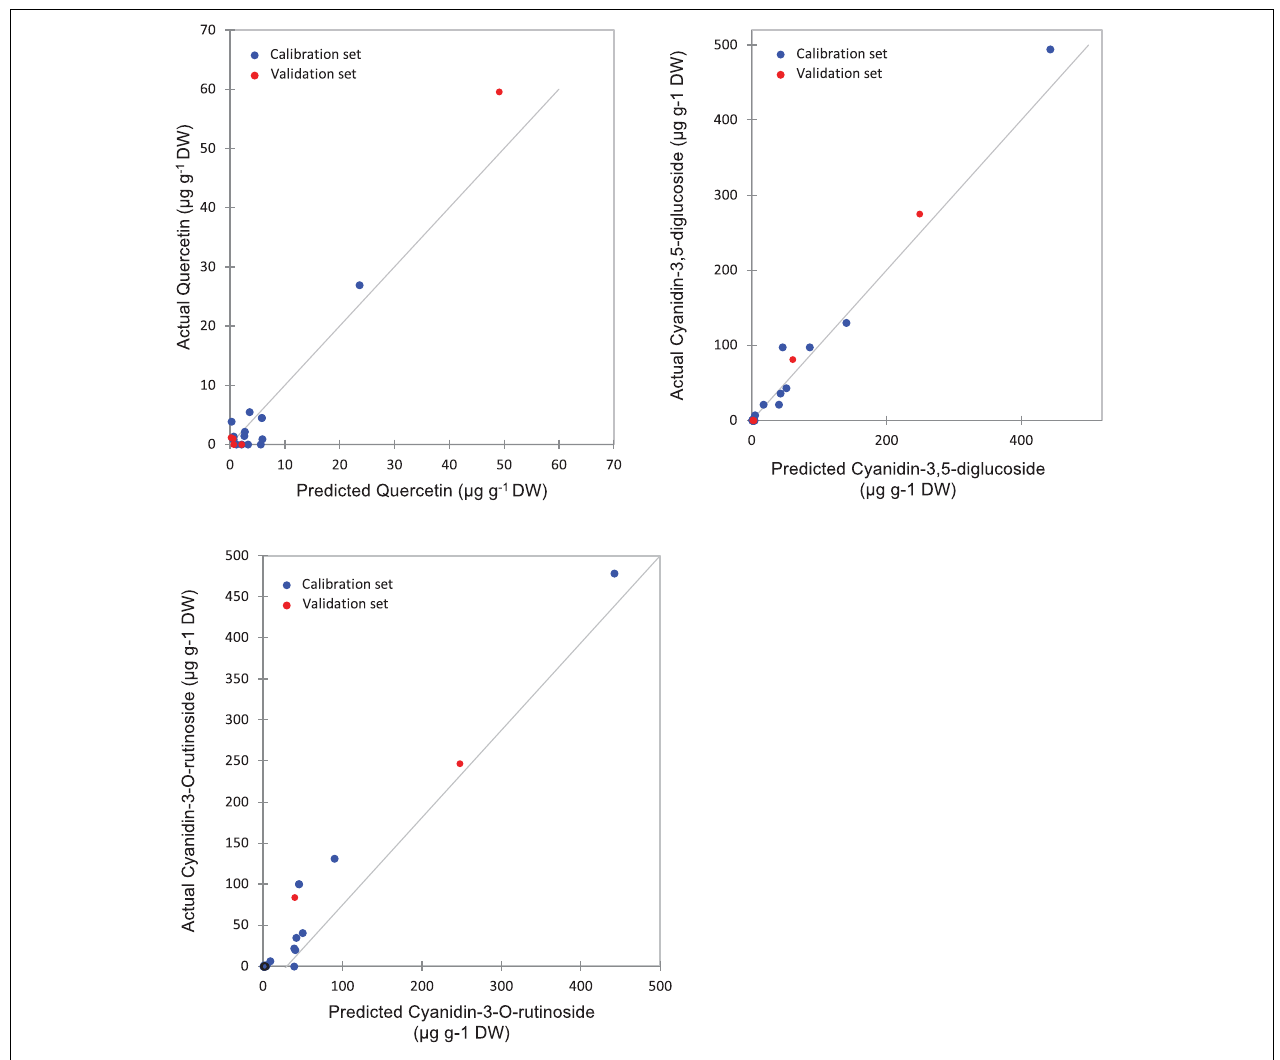
FIGURE 5 | Correlation plots for the prediction of phenolic compounds in the peel samples using PLSR based on the FT-IR